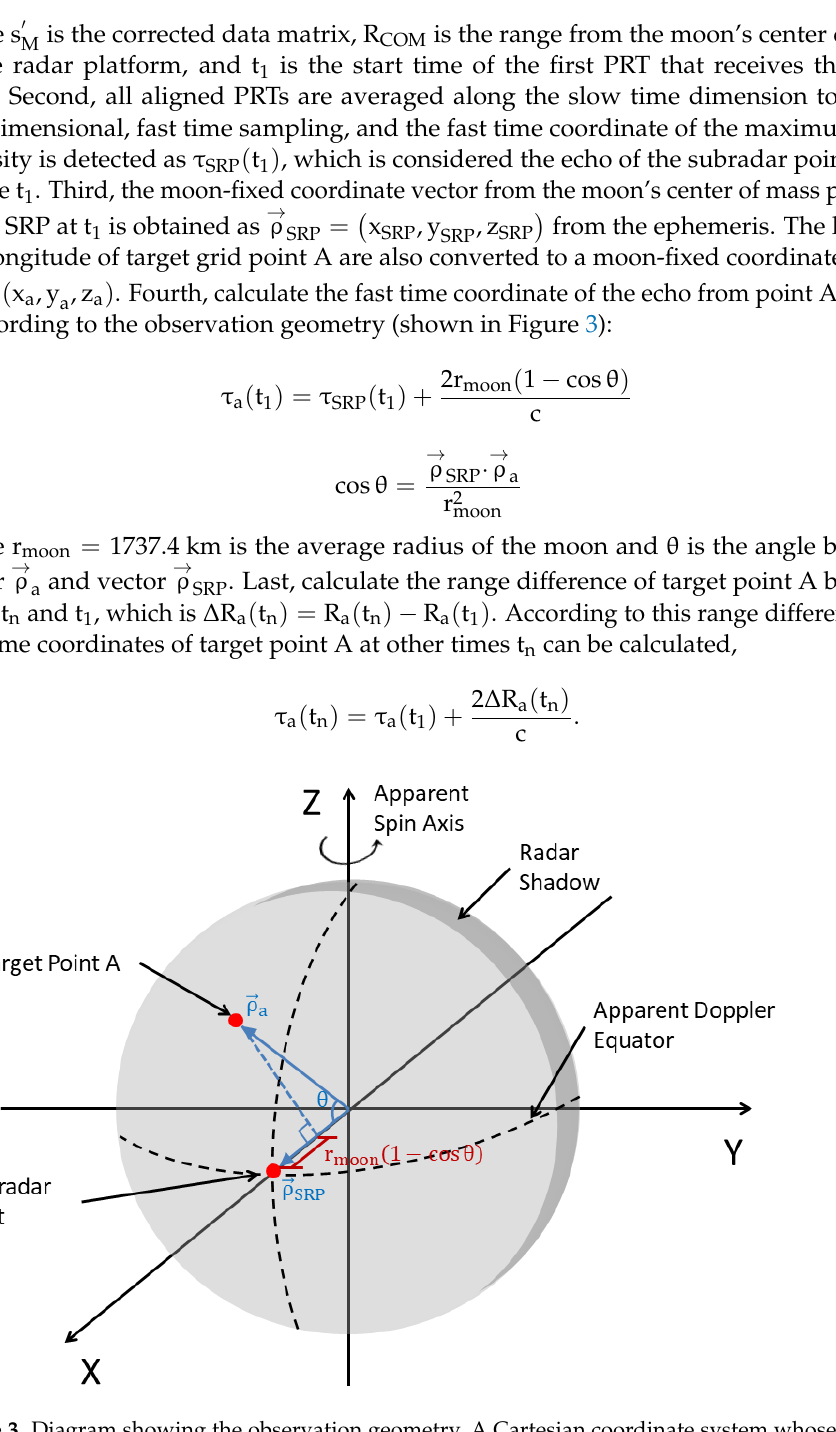
Figure 3. Diagram showing the observation geometry. A Cartesian coordinate system whose original point is located at the Moon’s center of mass (COM) is employed. The X-axis points to the radar and it is the range direction, the Z-axis extends along the apparent spin axis toward the north, and the Y-axis follows the right-hand